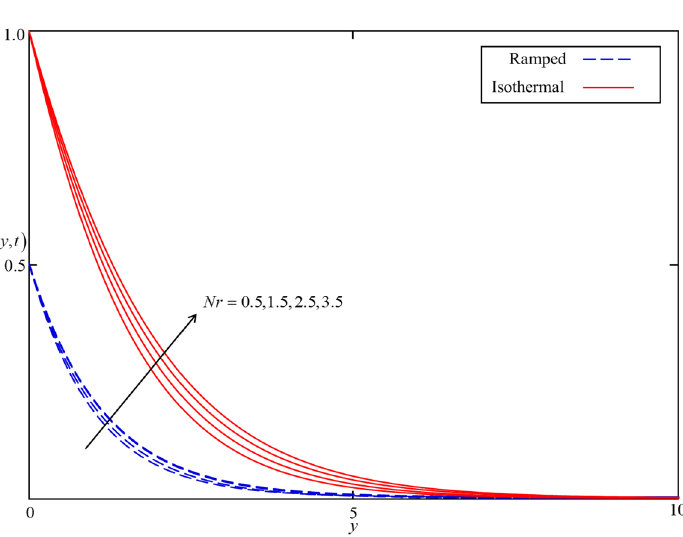
y , t when α = 0.5 , φ = 0.04 , β = 0.5 , (cid:30) (cid:31)